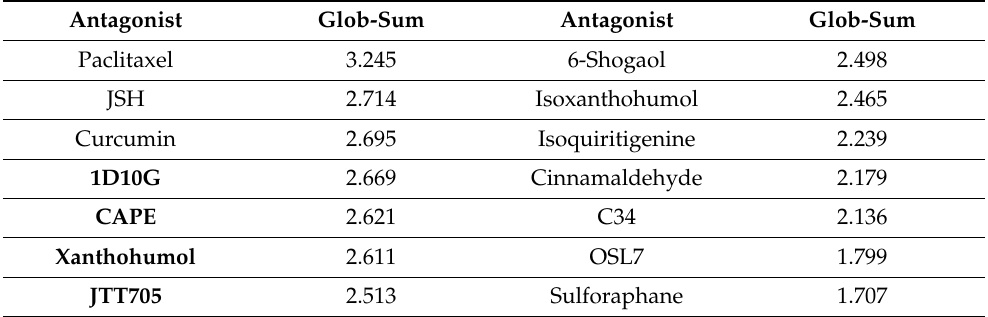
Table 1. Reference antagonists of MD-2 ranked by the Glob-Sum score obtained from structure-based virtual screening (SBVS) in descending order.